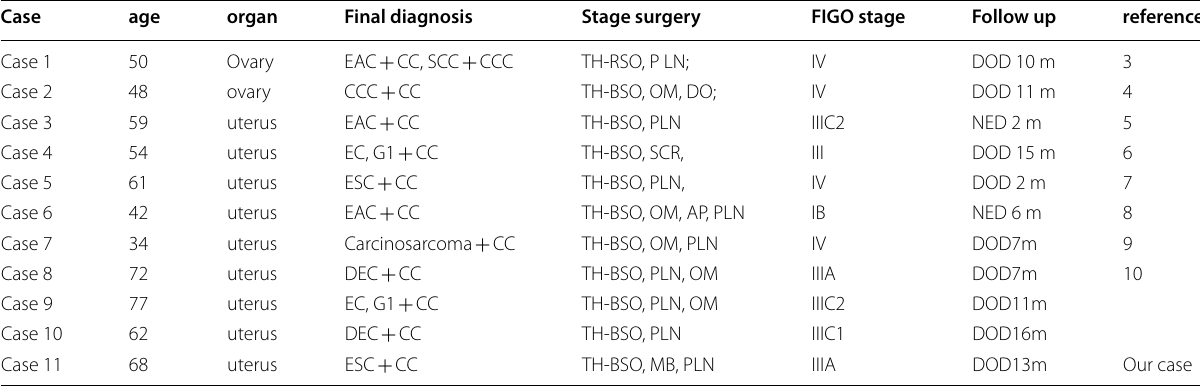
EAC Endometrial adenocarcinoma, CCC Clear cell carcinoma, SCC Small cell carcinoma, ESC Endometrail serous carcinoma, DEC Dedifferentiated enodmetrial carcinoma, CC Choriocarcinoma, EC Endometrioid carcinoma, G1 Grade 1, TH-BSO Total hysterectomy with bilateral salpingo-oophorectomy, MB Multiple biopsies, TH-RSO Total hysterectomy with right salpingo-oophorectomy, PLN Pelvic lymphadenectomy, AP Appendectomy, OM Omentectomy, SCR Sigmoid colon resection, DO Debulking operation, DOD Dead of disease, NED No evidence of the